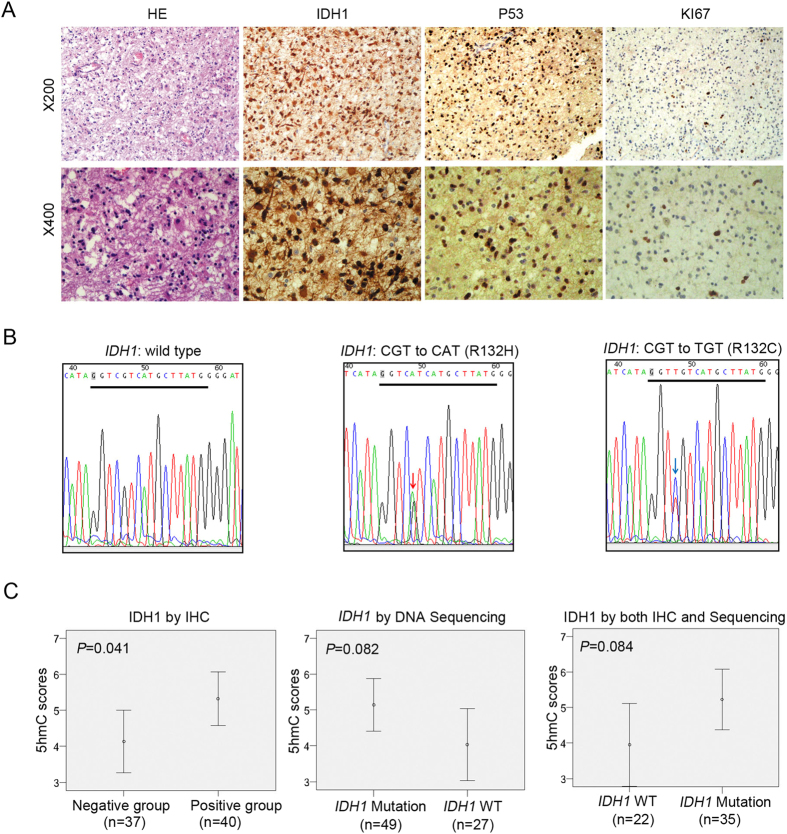
IDH1 mutation status is not associated with 5hmC reduction.(A) HE and representative immunostaining images of IDH1, P53 and KI67 in diffuse astrocytomas. 200× (upper), 400× (bottom). (B) Representative IDH1 wild-type (WT), IDH1 (red arrow, R132H) and IDH1 (blue arrow, R132C) mutations were analyzed by Sanger sequencing. (C) Comparison of 5hmC level in DA cases between with IDH1 mutation and wild type by immunohistochemistry (IHC), DNA sequencing, or both IHC and DNA sequencing using the unpaired Student’s t-test. Error bar represents the standard error.